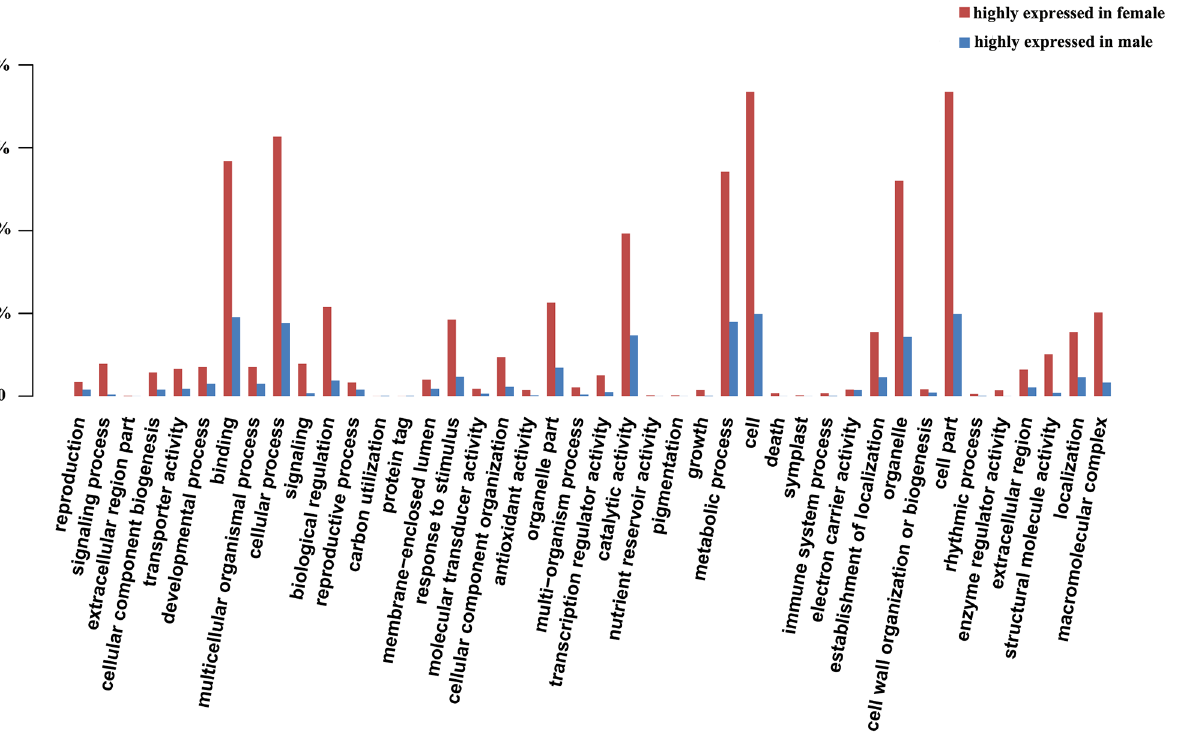
(Fig 4). Seventeen of these were validated by qRT-PCR. V-type proton ATPase subunit E, DELLA protein GAI, putative leucine-rich repeat receptor-like protein kinase family protein,